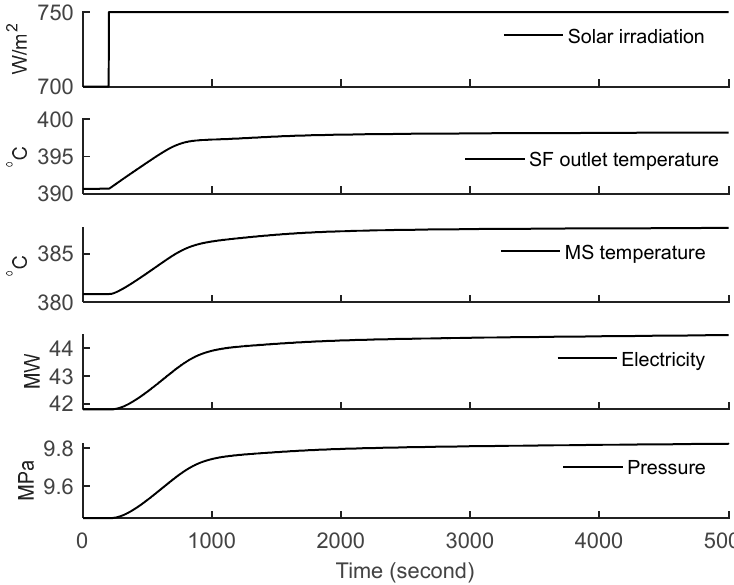
Figure 6. System response to step change of solar irradiation.